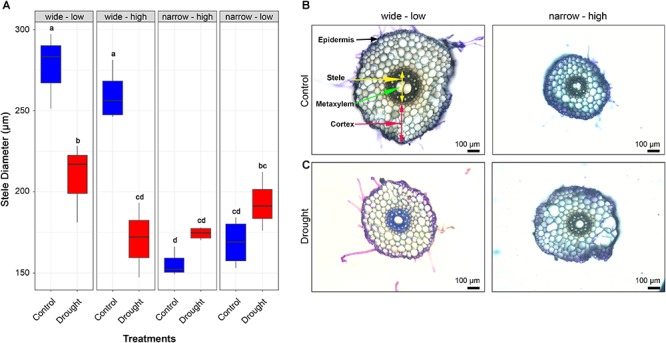
Anatomical features of roots sampled from durum wheat genotypes representative of distinct root system ideotypes. (A) Stele diameter of the four root ideotypes of samples collected 10 cm from root apex, under well-watered (control; boxplot colored in blue) and drought conditions (boxplot colored in red). Mean stele diameter with different letters above the boxplot are significantly different. Radial root cross sections on seminal root at 10 cm from root apex displaying anatomical variation in the root ideotype wide root angle with low biomass (B) and narrow root angle with high root biomass (C) under well-watered and drought conditions, scale bars in the cross sections = 100 μm.